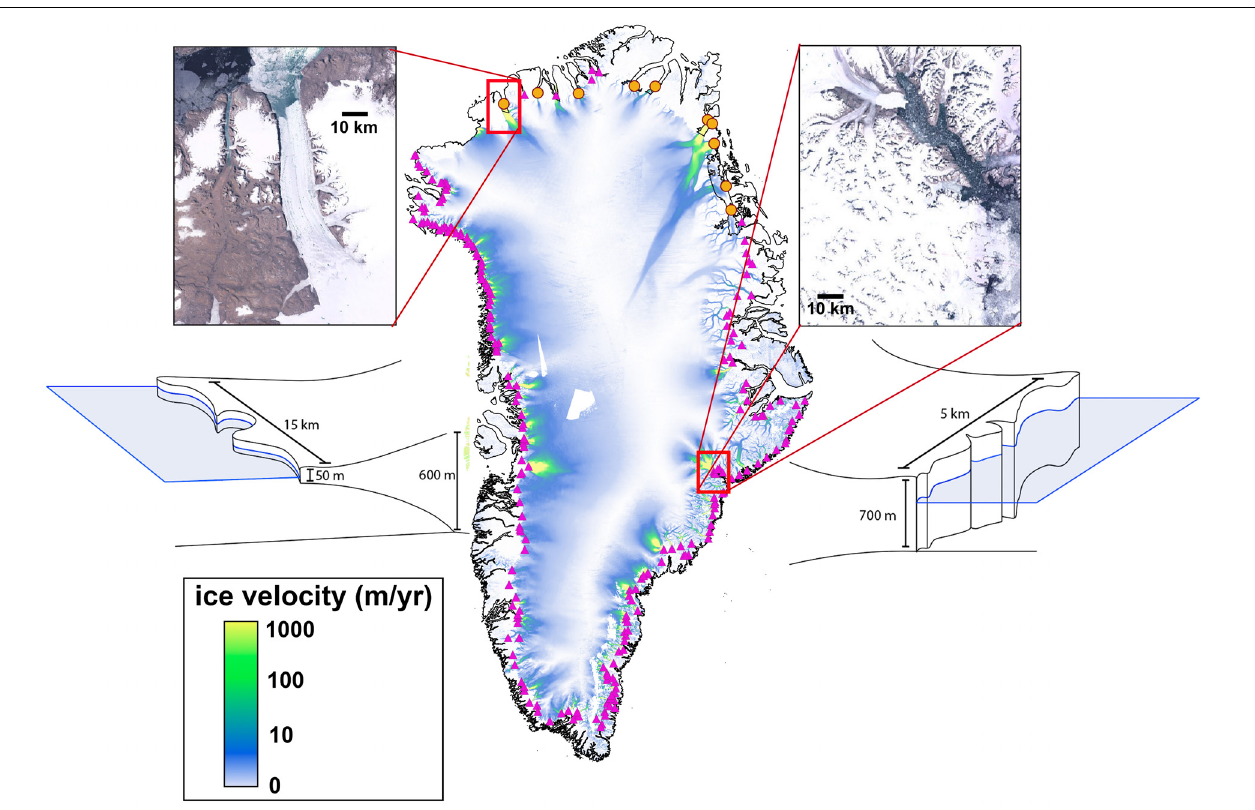
FIGURE 1 | The exchange of heat and freshwater between the ocean and the Greenland Ice Sheet occurs at the margins of over 200 marine terminating glaciers, visible as narrow areas of increased ice flow, distributed around the perimeter of Greenland that discharge into narrow, long and deep fjords. Several of these glaciers are characterized by long ( > 5 km) floating ice tongues (left inserts, orange circles) but most glaciers have lost their long floating regions (right inserts, pink triangles). Glaciers identified as having long floating ice tongues greater than 5 km in length, are determined through their height above floatation. Height above flotation is calculated using surface elevation data from the GIMP DEM (Howat et al., 2017) and ice bottom from BedMachine 3 (Morlighem et al., 2017). The background ice velocity is from a 2015–2016 mosaic (Joughin et al., 2017); glacier locations are from Rignot and Mouginot